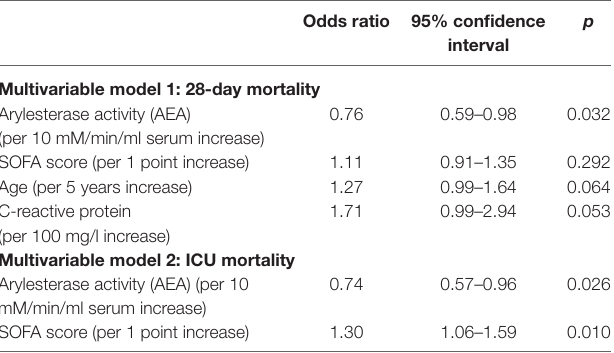
TABLE 4 | Two multivariable models for 28-day and ICU mortality of the sepsis cohort.